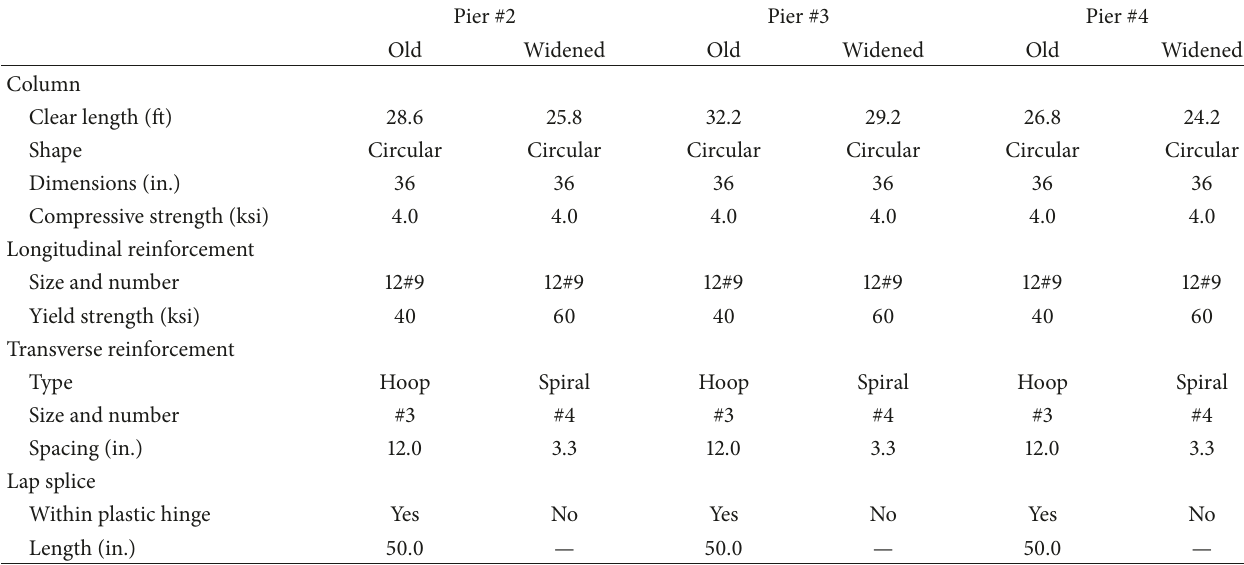
Table 2: Bridge #1-W columns’ geometric properties and reinforcement details ∗ .